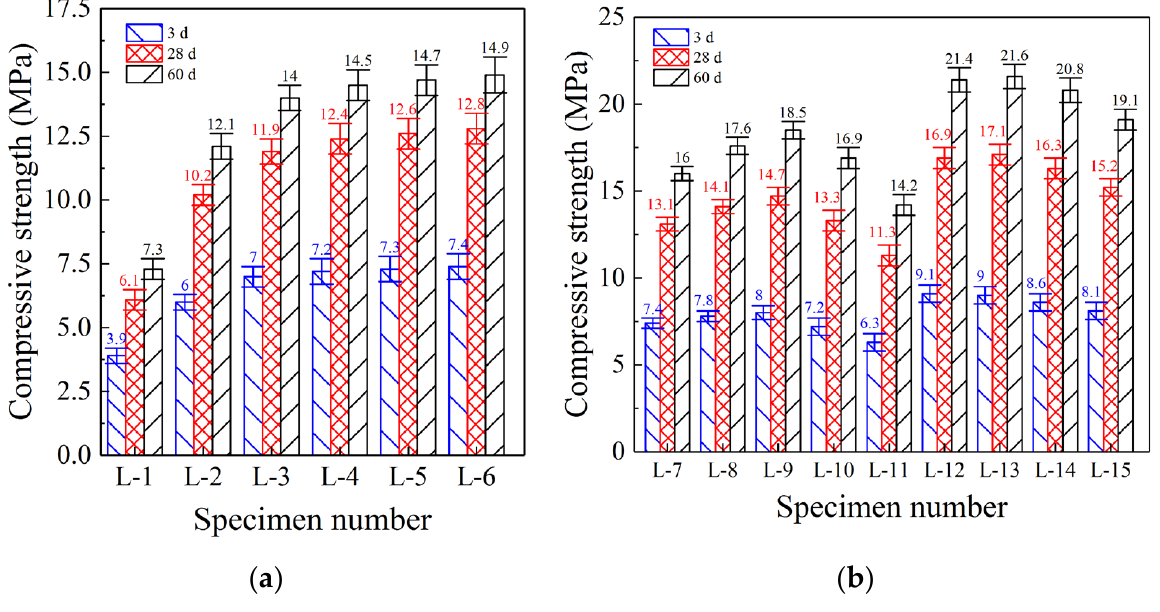
Figure 1. Compressive strength analysis. ( a ) Specimens L-1 to L-6. ( b ) Specimens L-7 to L-15 Table 3. Compressive Strength Analysis Results MPa.